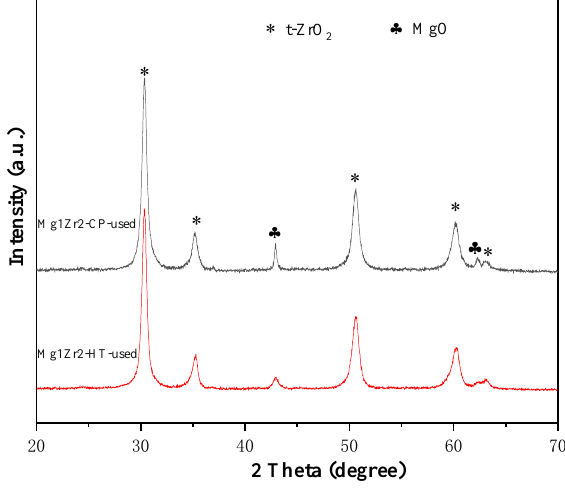
Figure 9. XRD patterns of Mg1Zr2-HT-used and Mg1Zr2-CP-used. It can be seen from Figure 10 that after transesterification, the particle sizes of both two catalysts increased significantly and the particle sizes became uneven, indicating that the catalyst particles appeared aggregate and sintering, resulting in the gradual increase of grain size and the decrease of dispersion. The Mg1Zr2-CP-used catalyst had serious agglomeration, while the Mg1Zr2-HT-used catalyst had slight sintering but no obvious agglomeration, indicating that the catalyst prepared by the hydrothermal process had strong sintering resistance. This is because under hydrothermal conditions, the compounds in the solution may renucleate and restructure, so that the particles after hydrothermal treatment have better dispersion and grain stability than those particles only by neutralization precipitation [42].